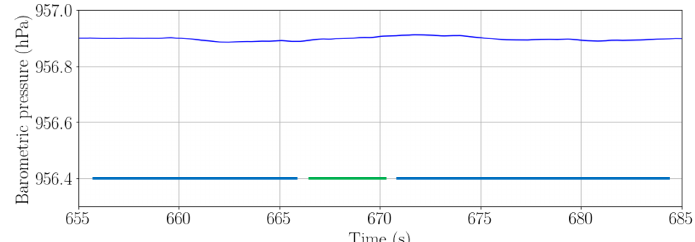
Figure 11. Barometric pressure when a passenger is walking a 1.2m high staircase with a hand- held smartphone. The green solid line indicates the moment when the passenger is climbing a stair- case. The blue solid line indicates the moment when the passenger is walking on a horizontal surface.